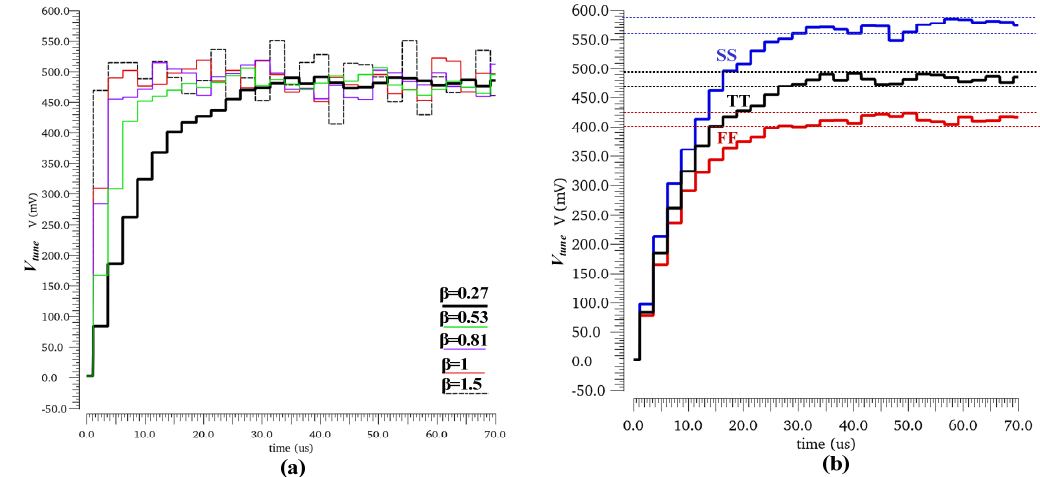
Figure 22. The simulated settling waveforms of V tune ( a ) with di ff erent values of β , and ( b ) under process variation with a constant β = 0.27.